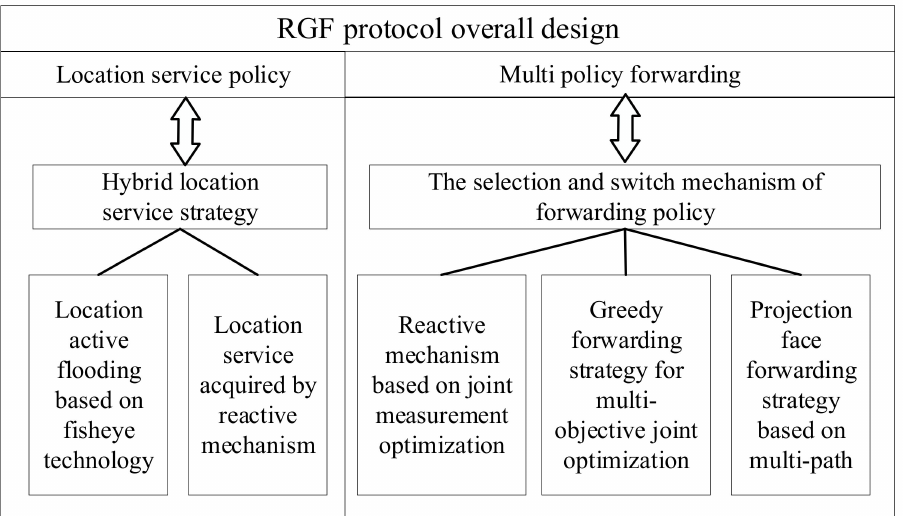
Figure 1. RGF protocol overall